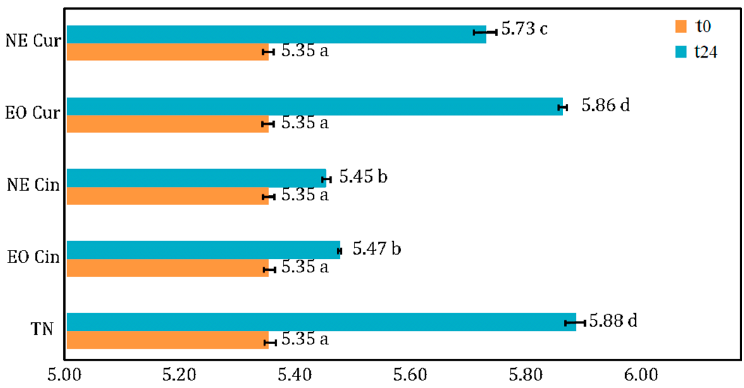
Figure 3. pH measurements of the control (TN) and minced meat treated with cinnamon EO (Cin EO), cinnamon NE (Cin NE), curcuma EO (Cur EO), and curcuma NE (Cur NE) at t = 0 and t = 24 h. Means with different letters were significantly different at the level of p < 0.05.